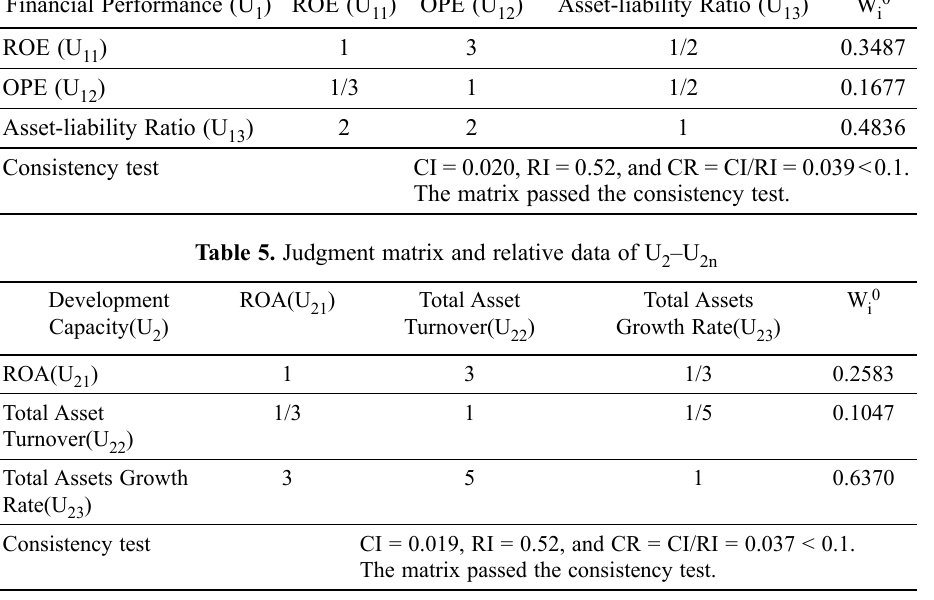
Table 4. Judgment matrix and relative data of U